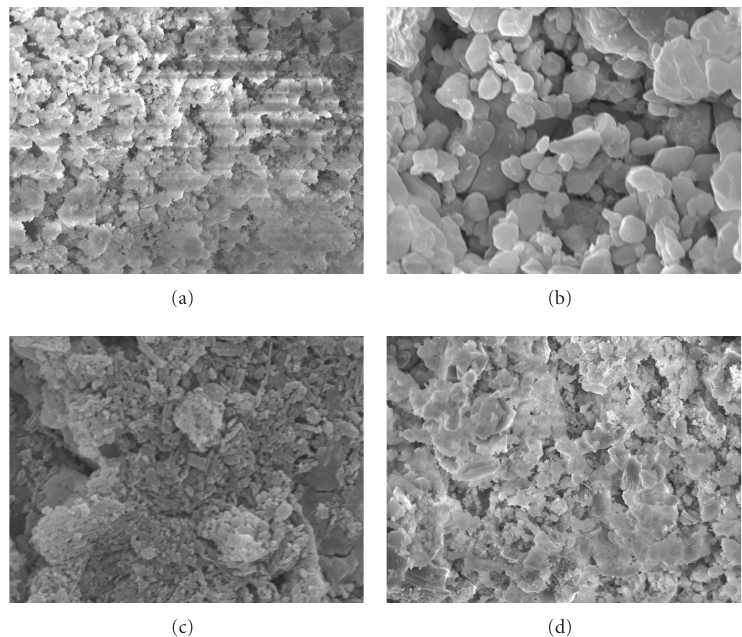
Figure 6: SEM pictures of Buccinum tenussimum shell biomass after adsorption of metals. (a) ground original sample, (b) heat-treatment (480 ◦ C) sample, (c) heat-treatment (950 ◦ C) sample, and (d) heat-treatment (950 ◦ C) and water-added sample.